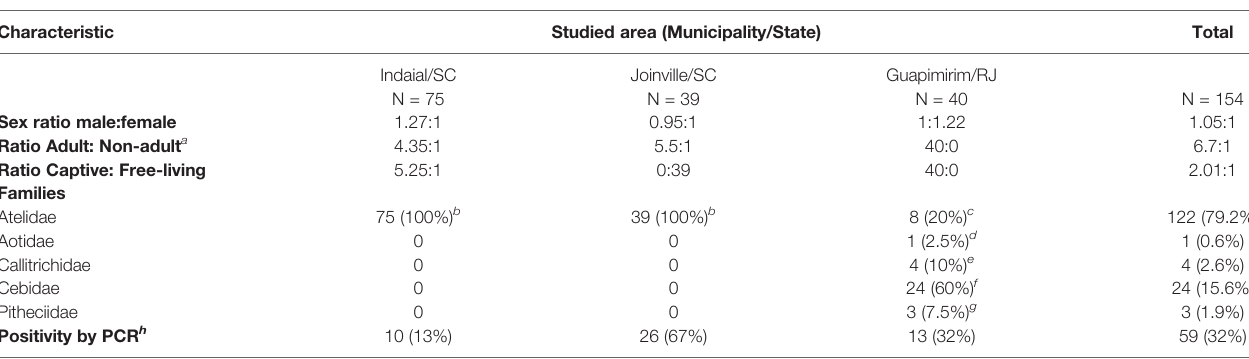
TABLE 1 | Characteristics of monkeys from each studied area.